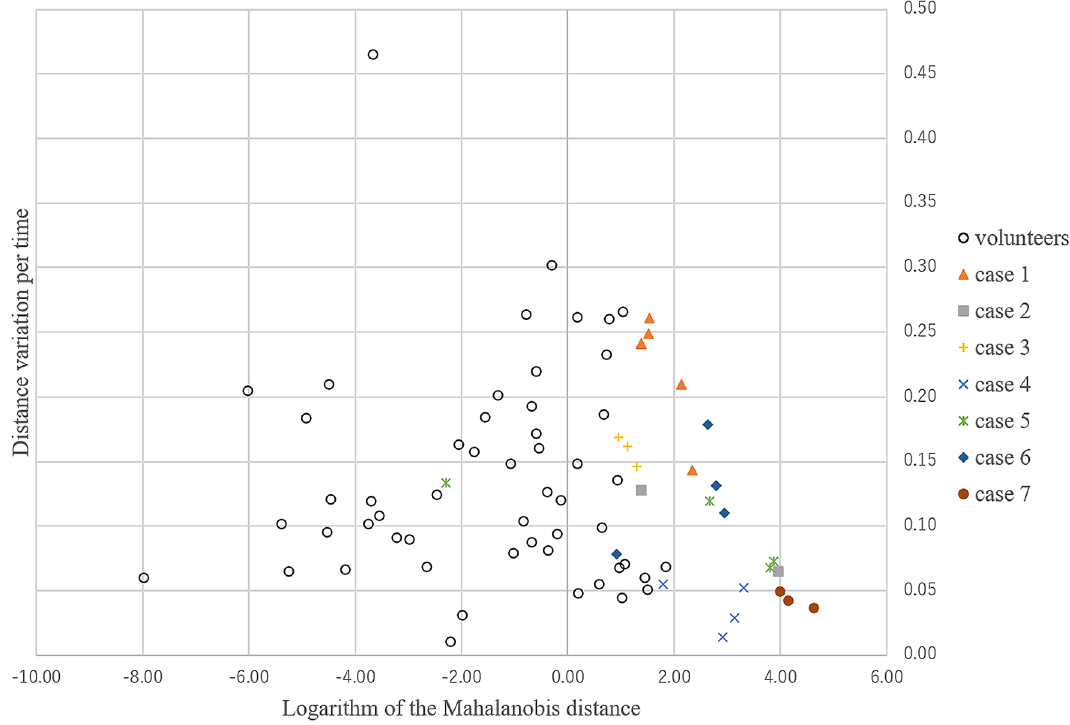
Figure 8. Scatter diagram of the logarithm of the Mahalanobis distance (horizontal axis) and distance variation per time (vertical axis) in patients with chronic intestinal pseudo-obstruction and healthy